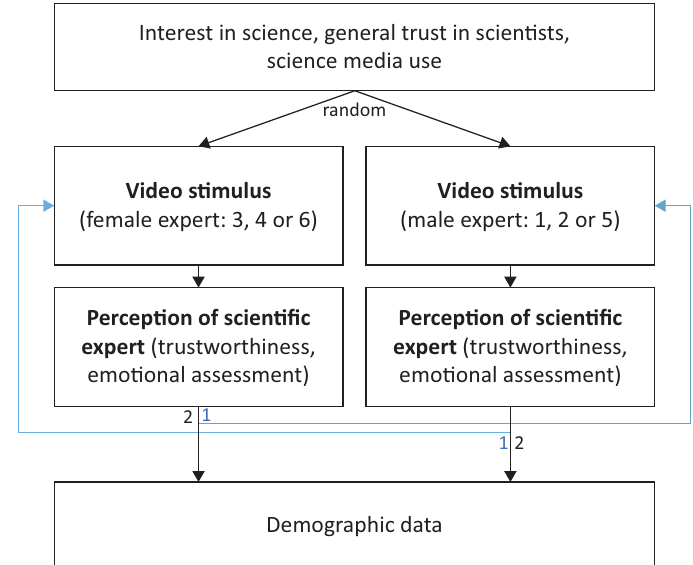
Figure 1. Experimental design of the study.